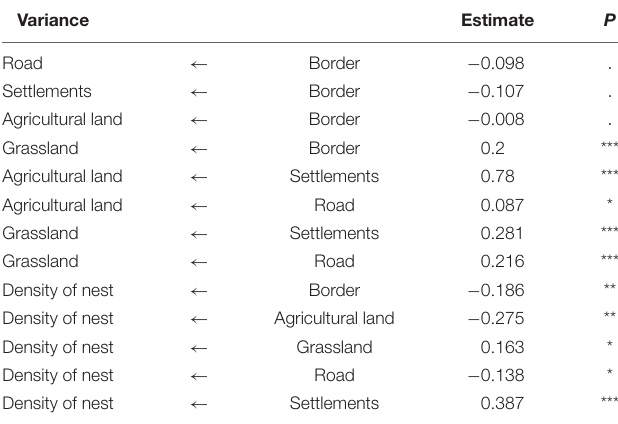
TABLE 1 | Results of the structural equation